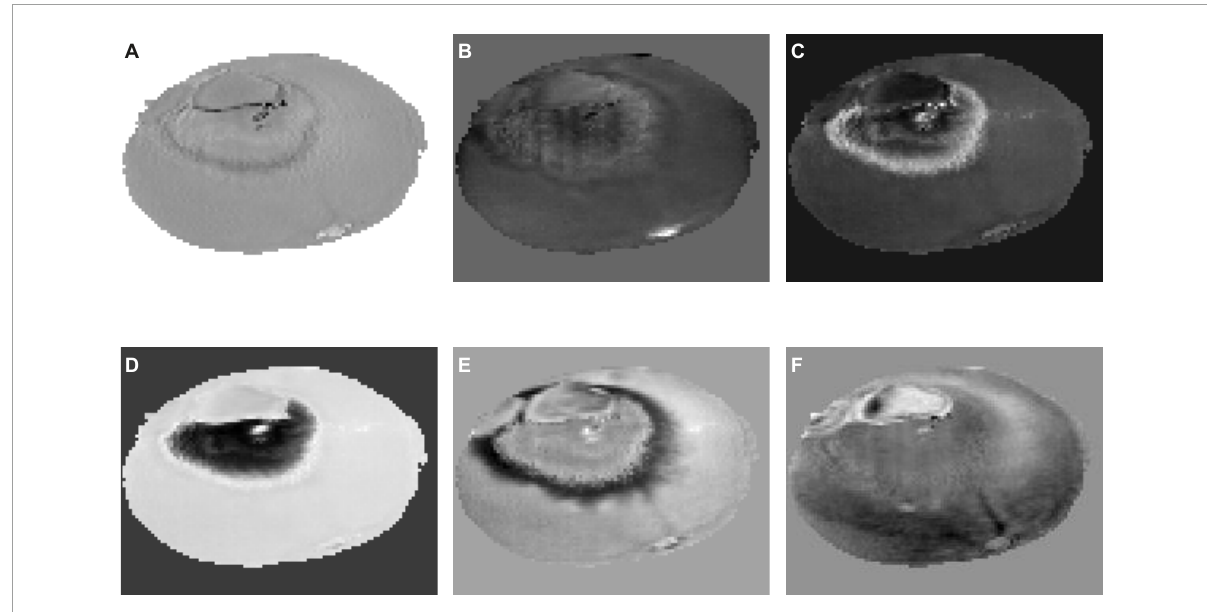
FIGURE7 Six independent component images by independent component analysis. (A) ICA01, (B) ICA02, (C) ICA03, (D) ICA04, (E) ICA05, (F) ICA06.